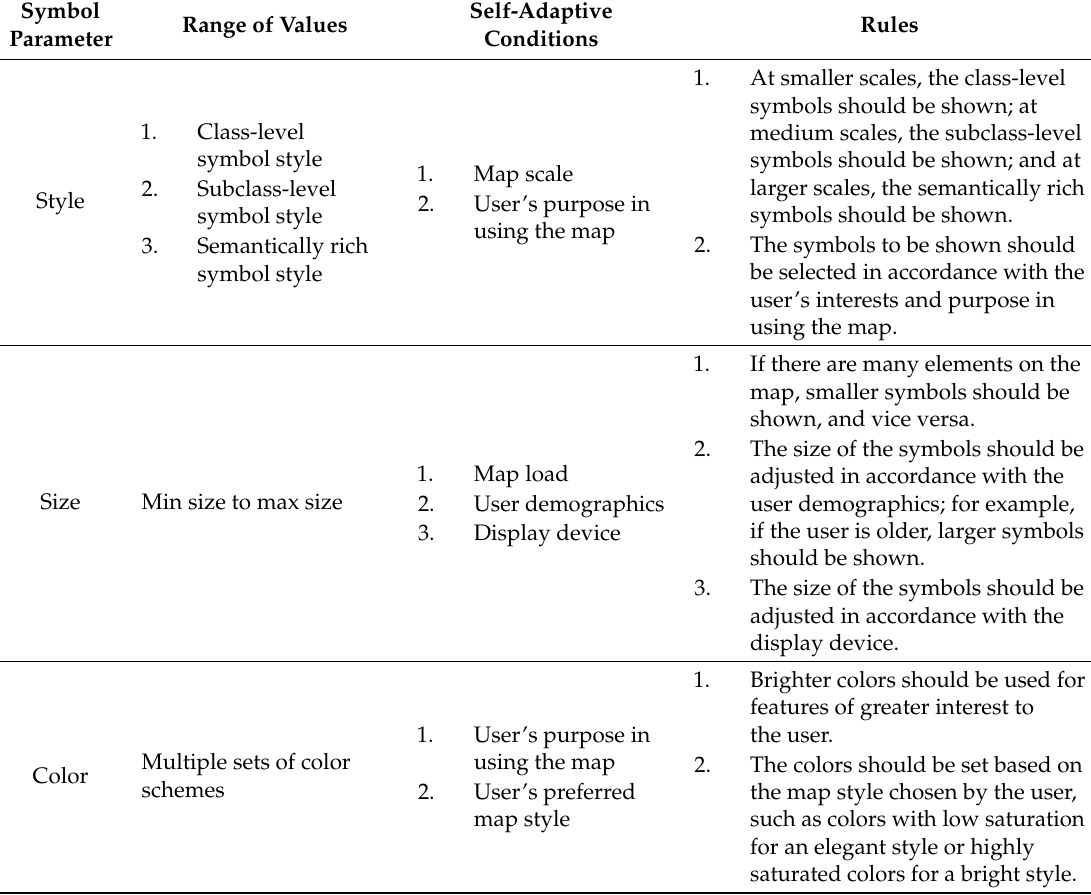
Table 5. Rules for adaptive symbol parameter